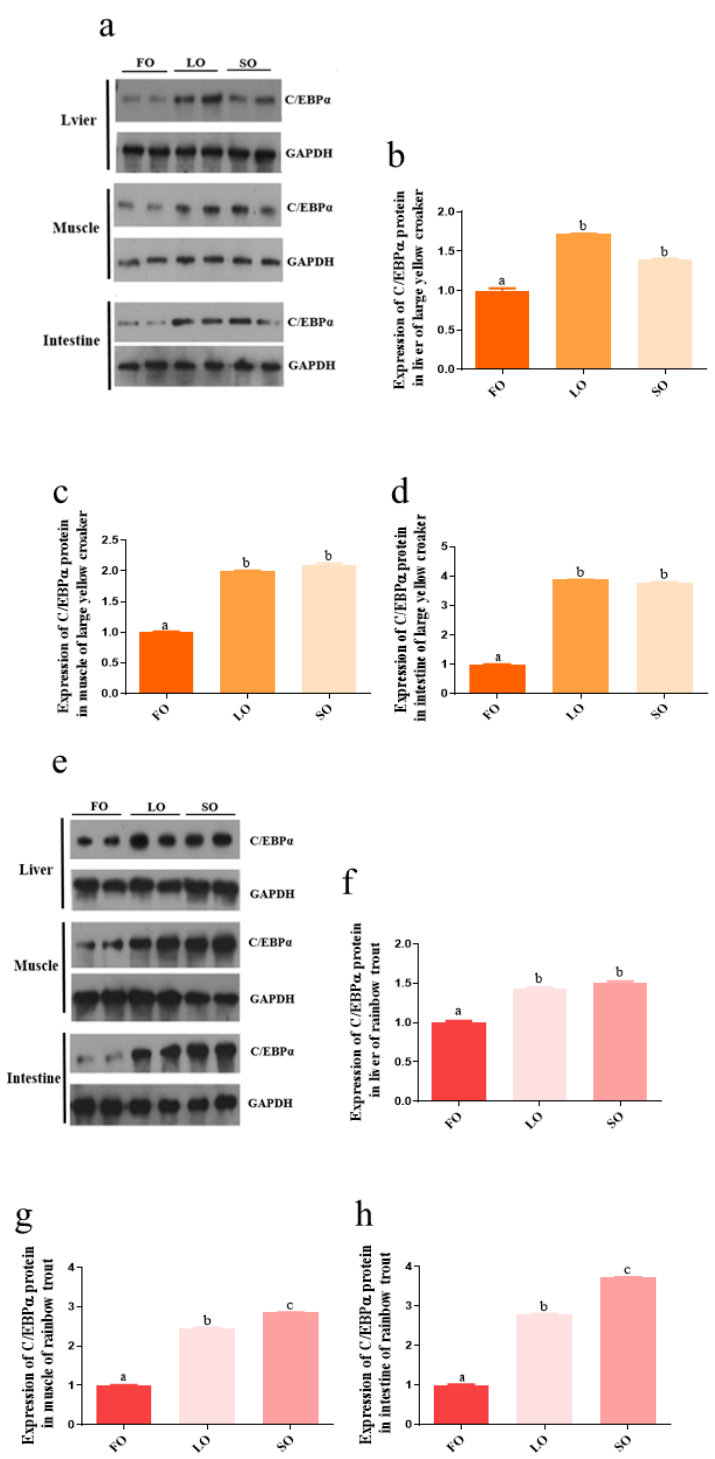
Figure 6. The relative expression of C/EBP α protein in tissues of large yellow croaker ( a – d ) and rainbow trout ( e – h ). Bars without sharing a common letter are significantly different ( p < 0.05). FO: 100% fish oil as a lipid source in the diet. LO: 100% linseed oil as a lipid source in the diet. SO: 100% soybean oil as a lipid source in the diet.